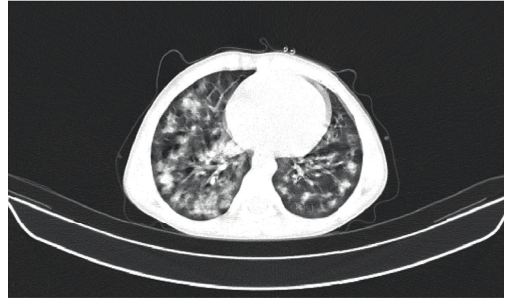
Figure 2: Tomography upon admission to the emergency